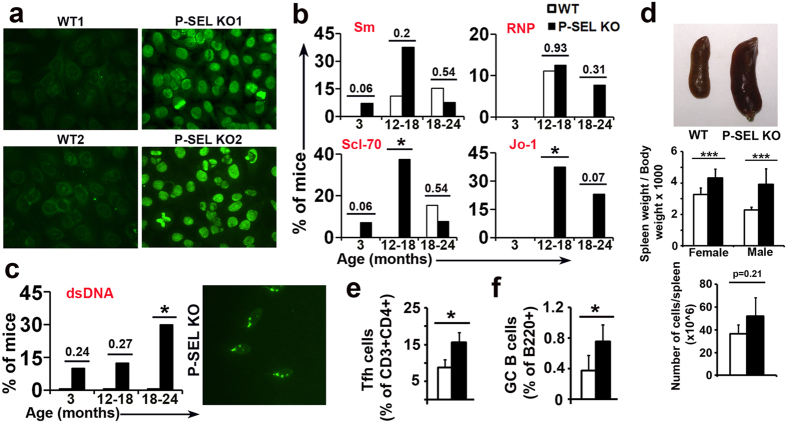
Spontaneous generation of autoantibodies related to connective tissue autoimmune diseases in P-Sel−/− mice.(a) Representative immunofluorescence photomicrographs of HEp-2 cells incubated with serum from 2 independent wild-type (WT) and 2 independent P-Sel−/− mice. (b) Percentage of mice positive for anti-Sm, RNP, Scl-70 and Jo-1 autoantibodies (n = 8–10 animals per group); *p < 0.05 by Chi-square test. (c) Percentage of mice positive for anti-dsDNA autoantibodies (n = 8–10 animals per group); *p < 0.05 by Chi-square test. Immunofluorescence photomicrographs of C. luciliae incubated with serum of a P-Sel−/− mouse (right panel). (d) Photograph of representative spleens of 3-month-old WT and P-Sel−/− mice (upper panel). Spleen weight/body weight ratio of female and male 3-month-old WT and P-Sel−/− mice (middle panel) (n = 6 mice per group). Total number of cells per spleen of WT and P-Sel−/− mice (lower panel). (e,f) Percentage of splenic follicular T helper (Tfh) cells (e) and germinal center (GC) B cells (f) in 3-month-old male WT and P-Sel−/− mice. *p < 0.05; ***p < 0.005 by Student’s two-tailed t-test. Bars show the mean ± standard deviation (SD).